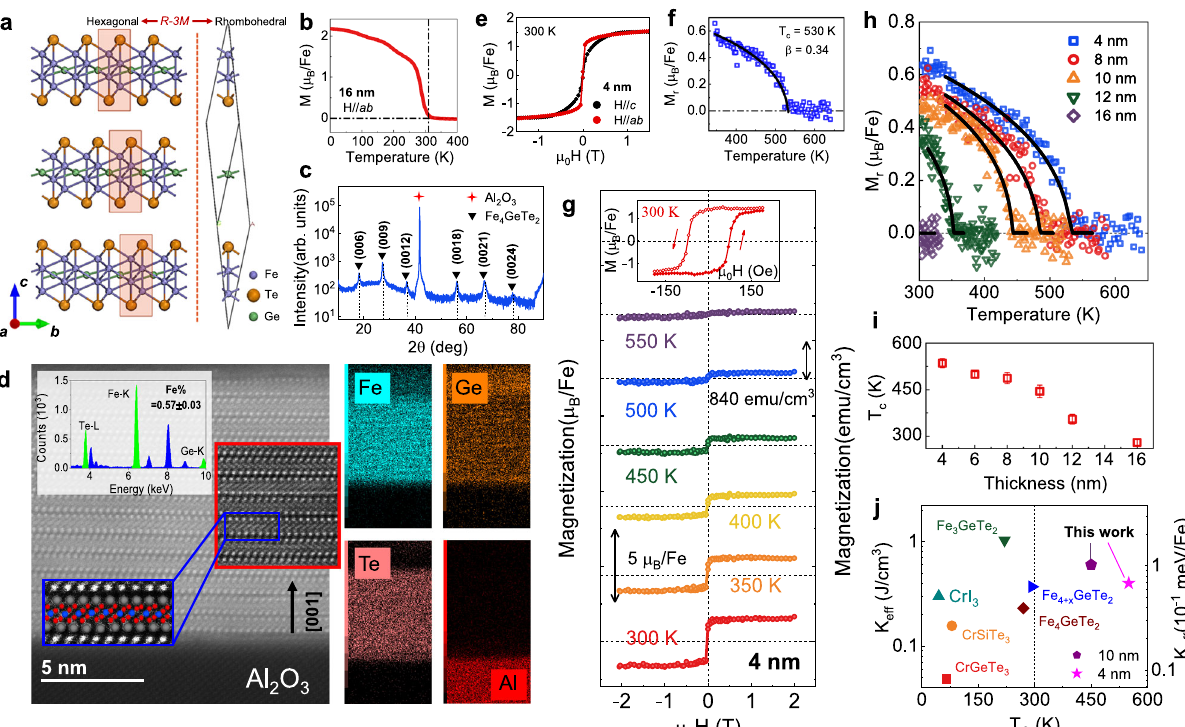
Fig. 1 | Crystal structure of the Fe 4 GeTe 2 and its thickness-dependent mag- netism. a Schematics of the crystal structure of Fe 4 GeTe 2 stacked in ABC con fi g- uration (left), and its rhombohedral structure unit (right). b Temperature dependenceofthe magnetization for 16nm Fe 4 GeTe 2 . c XRD scan of the Fe 4 GeTe